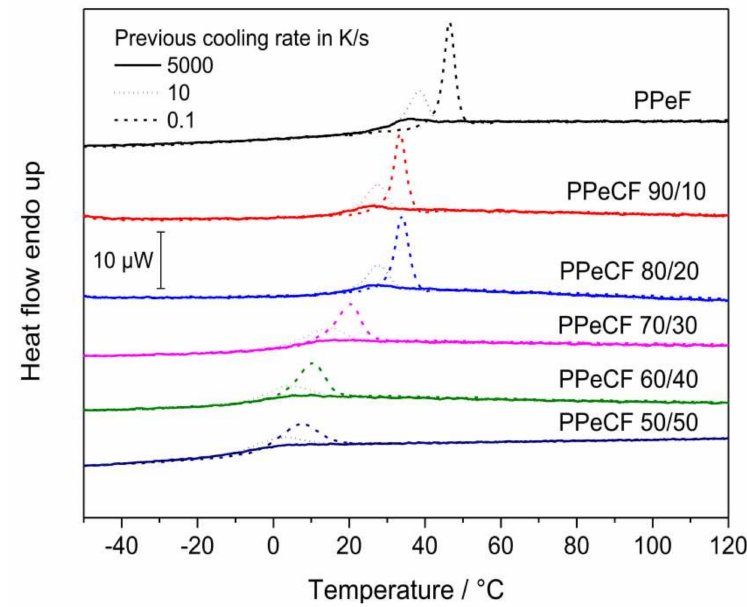
Figure 6. Fast scanning calorimetry (FSC) data of T g for PPeF- co -PCL copolymers [95].